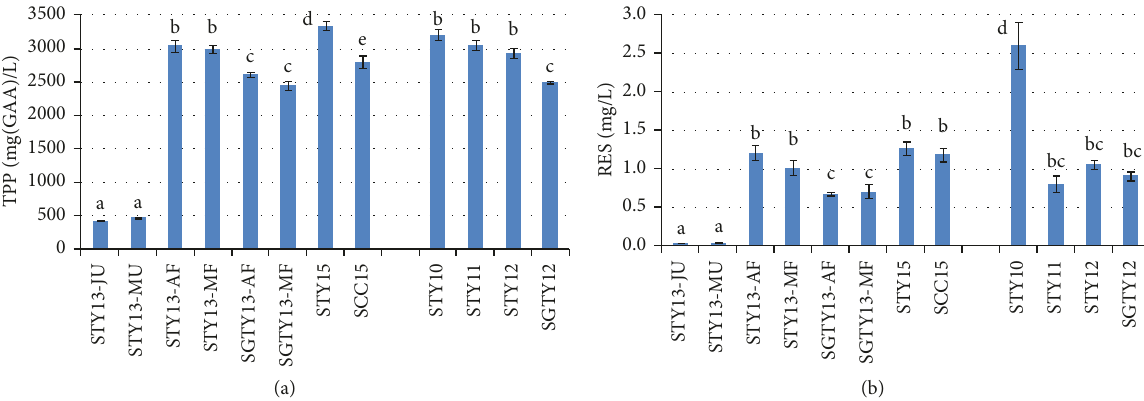
Figure 1: The content of (a) total polyphenols (TPP, mgGAA/L) and (b) trans -resveratrol (RES, mg/L) in grapes and wines samples. Values (mean esd) obtained from three samples and three replicates each sample, different letters indicate significant differences ( p test). Full experimental data sets are reported in Table ±